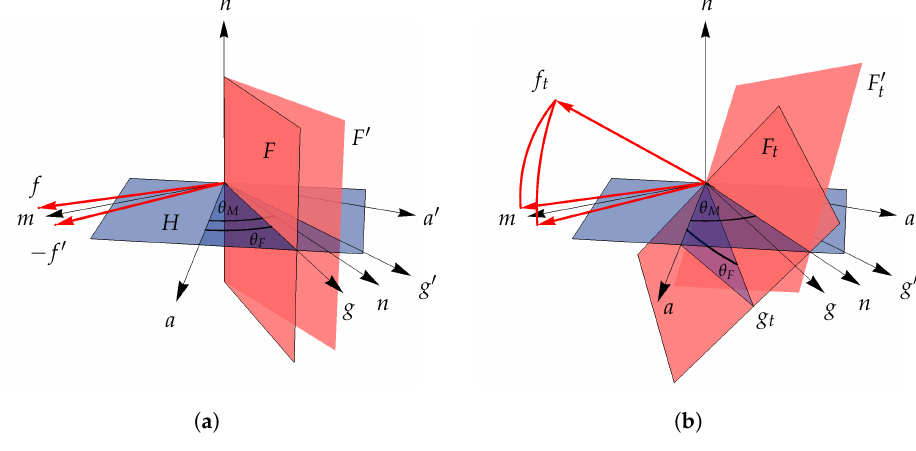
Figure 5. The twist transformation, in the 3-space of Hh . Bivectors F and F (cid:48) are shown: ( a ) in the initial state; and ( b ) in the final state, where they are equal, having been rotated clockwise around a and a (cid:48) , respectively, until meeting in F t = F (cid:48) t , which contains n . Their normals f and − f (cid:48) also rotate around a and a (cid:48) , to where they meet in the mh plane, perpendicular to n . This exactly matches the behavior of g and g (cid:48) in Figure 4 above.